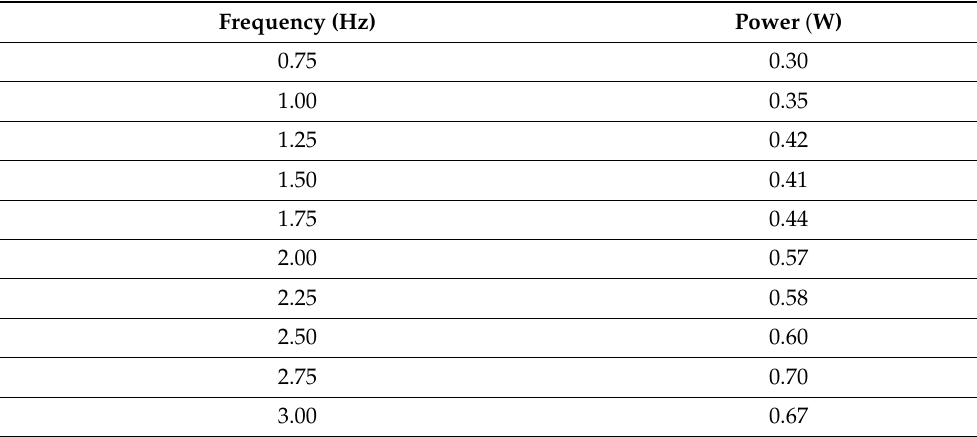
Table 6. Frequency data and relative power consumption